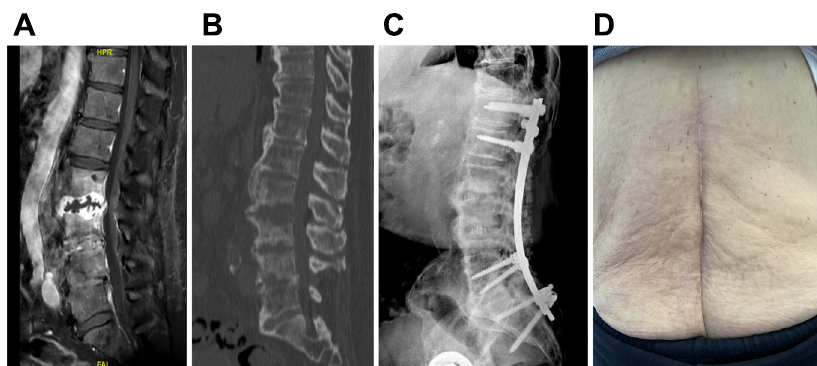
Fig. 2 Imaging of the patient before and after treatment. A Gadolinium T1-weighed MRI of the spine showing L2-L3 disc abscess and L3-L4 spondylodiscitis; B CT-scan showing mirror-like bone destruction from either side of the L2-L3 abscess; C X-ray performed at the end of the follow-up showing no loosening of the spinal osteosynthesis and the adequate position of the intersomatic cages at L2-L3 and L3-L4 level with anterior bone fusion; D Local aspect of the lumbar scar at the end of the follow-up, showing no in fl ammation nor discharge.